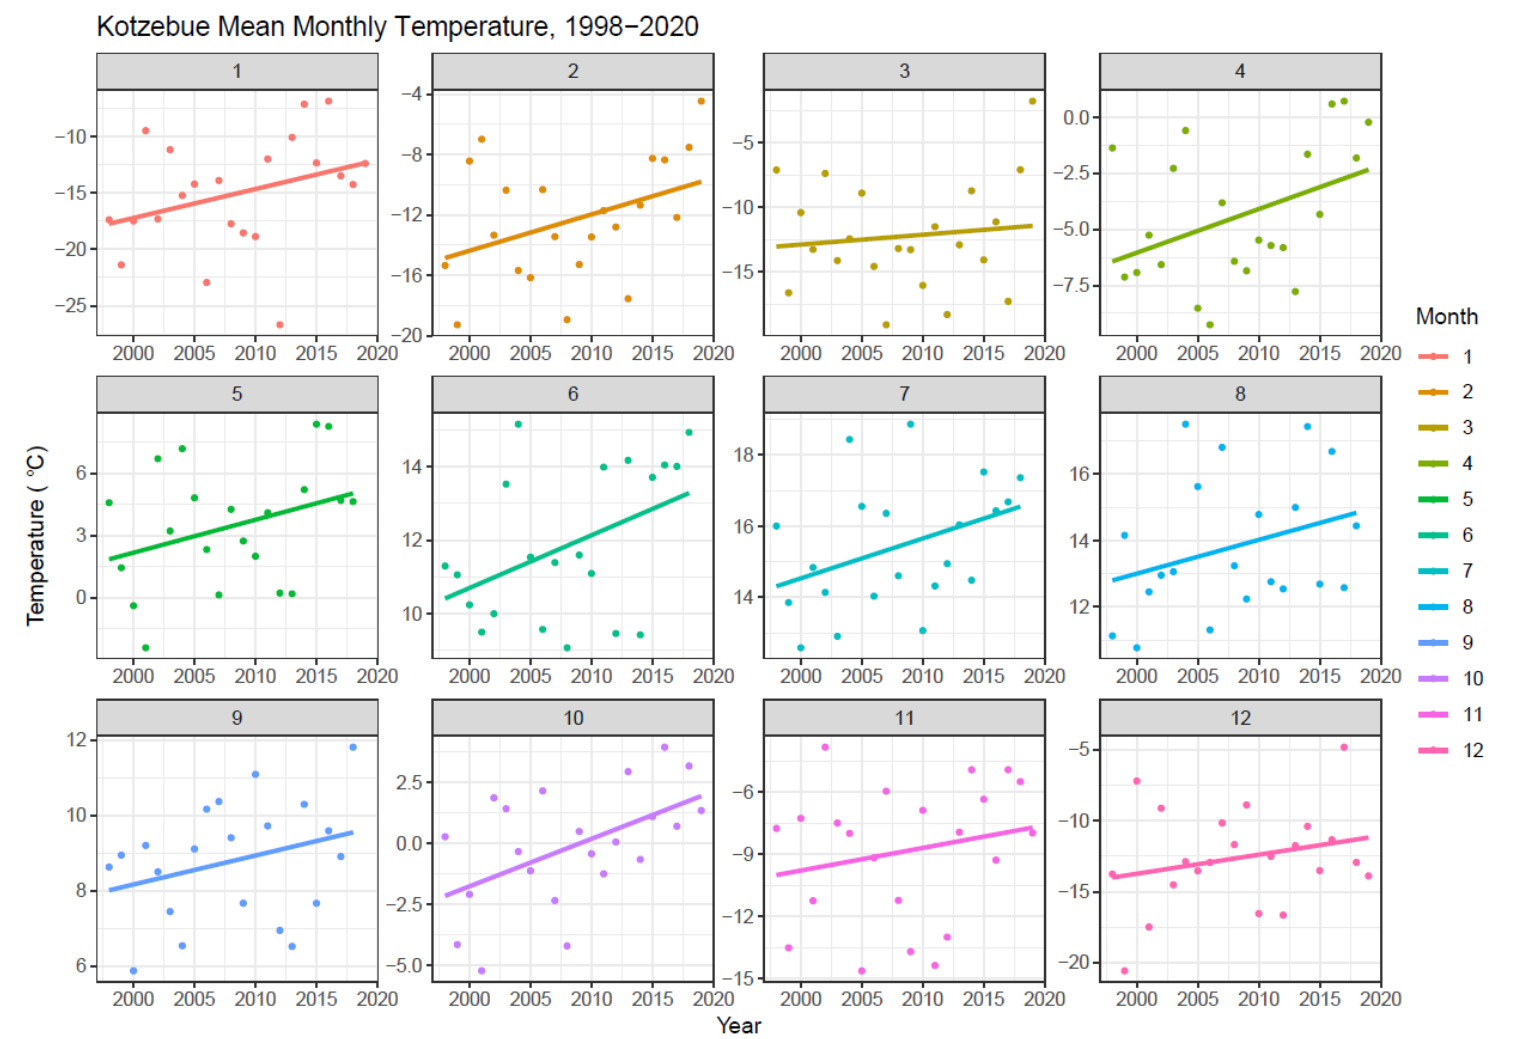
Figure A2 . 1 Trends in air temperature in Kotzebue, Alaska, from 1998 to 2020. Points are the average of daily temperature values for each month. Lines are predicted values from linear regression models fitted to the data (see Table A2.2). Data source: NOAA National Center for Environmental